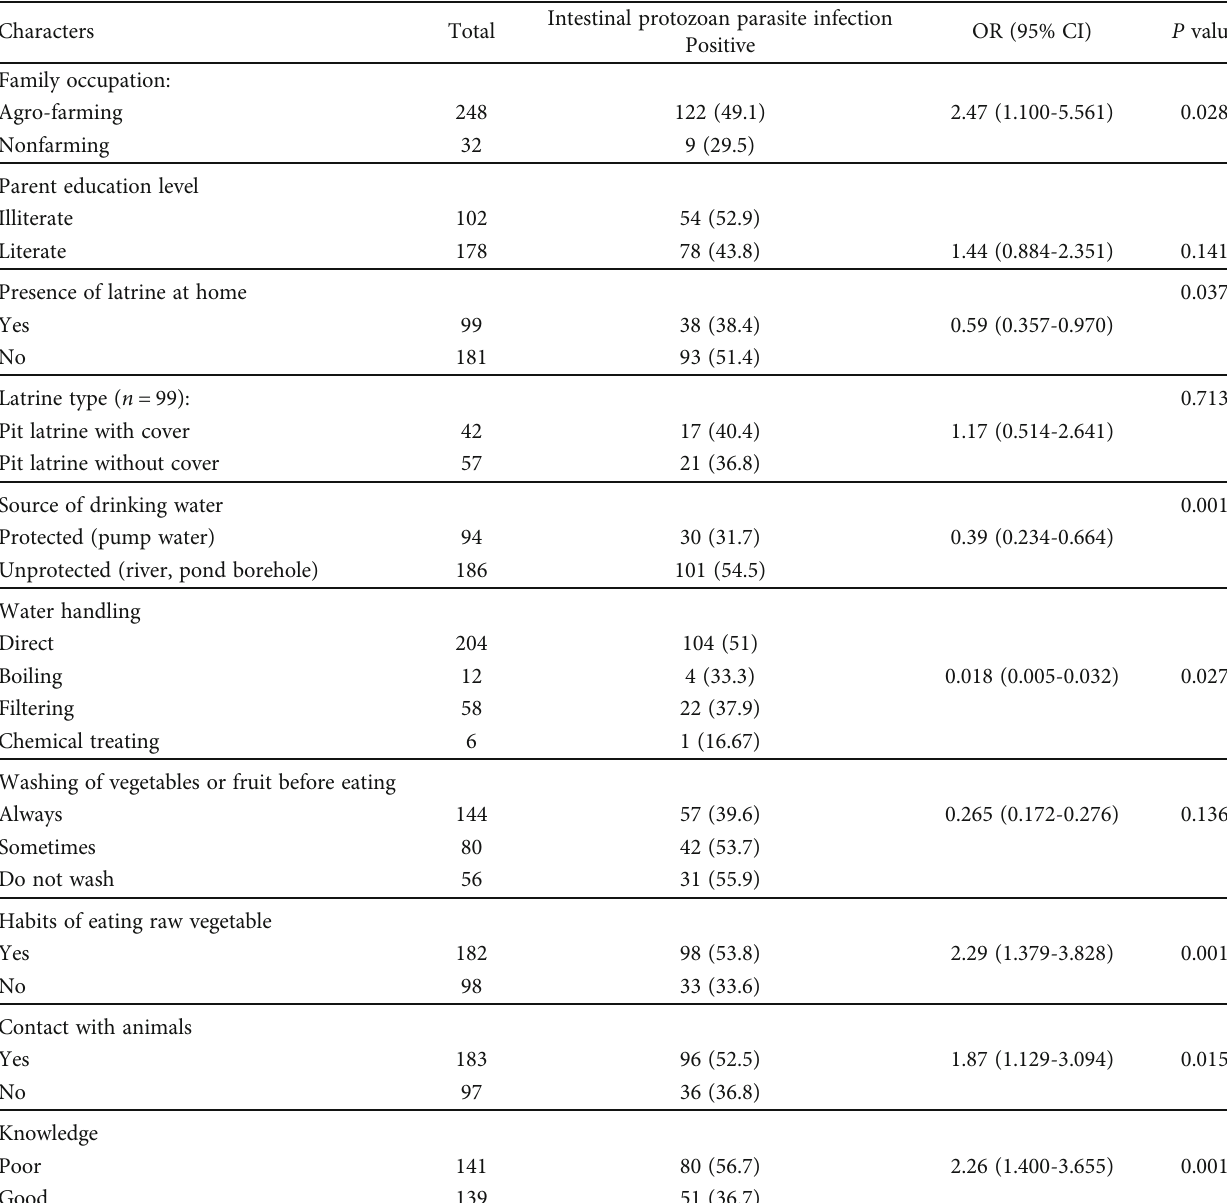
Table 4: Association of sociodemographic risk factors with intestinal protozoan parasite infection of school children in Merhabete district, Central Ethiopia,